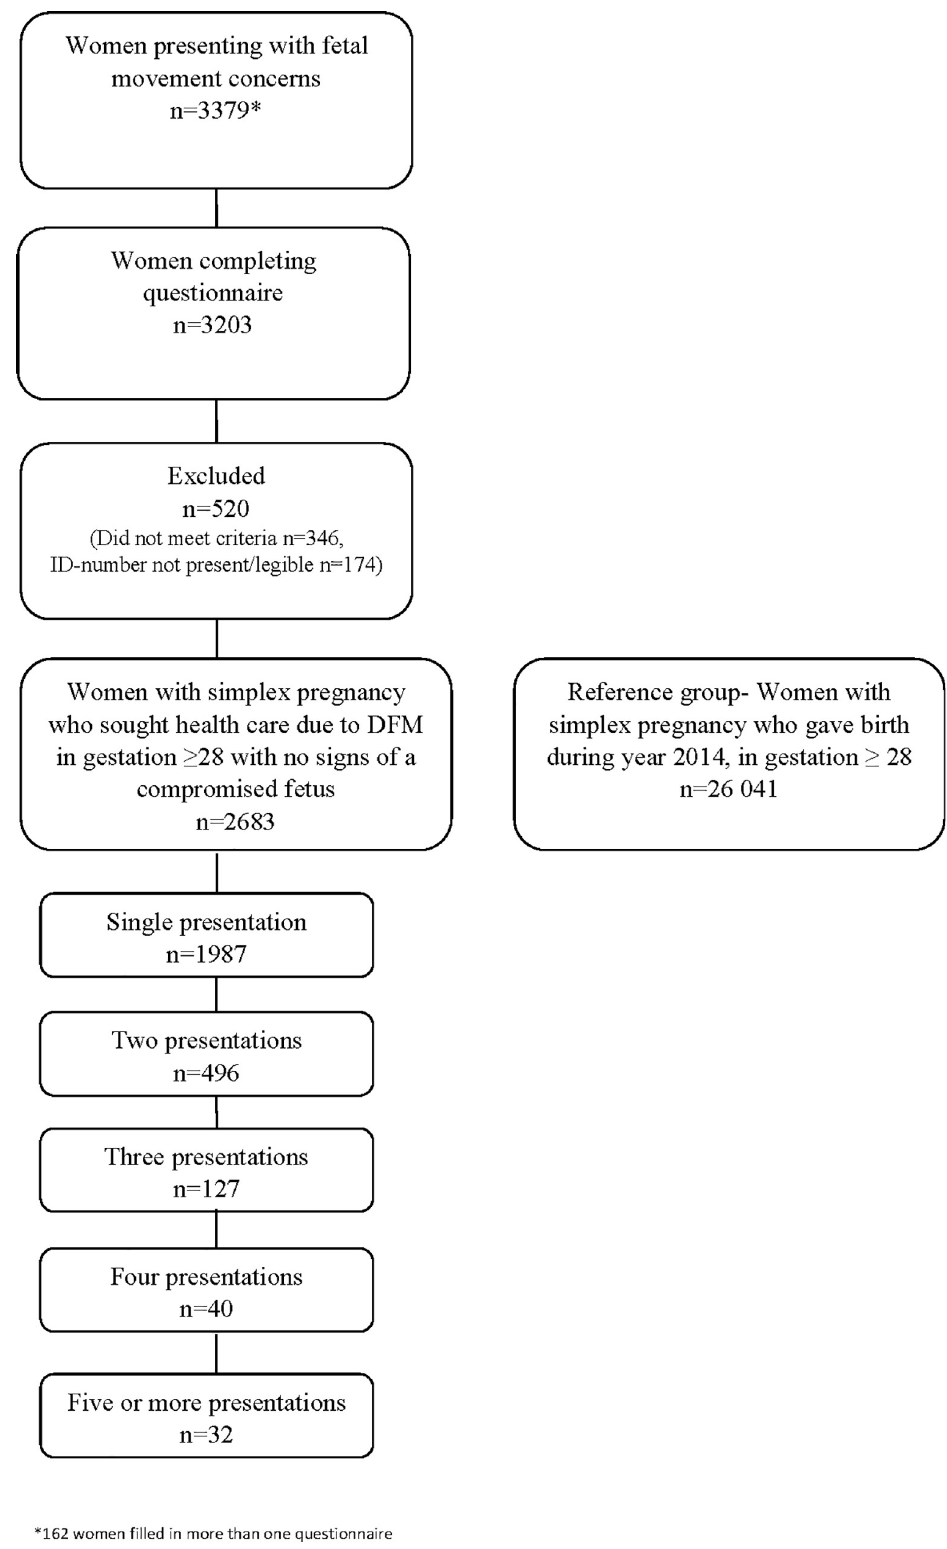
Fig 1. Flow chart describing the study